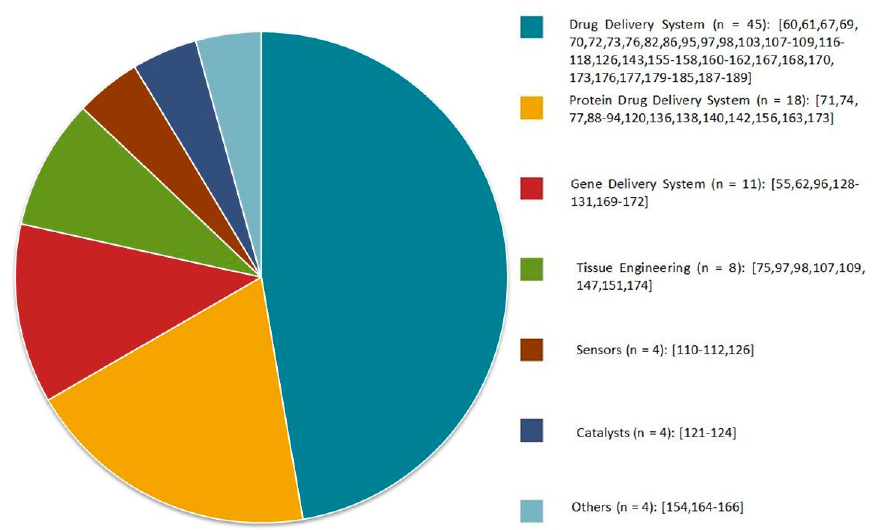
Figure 10. Applications of α -CD-based polypseudorotaxane hydrogels presented in the scientific literature in recent years. Citations concerning specific applications have been included.